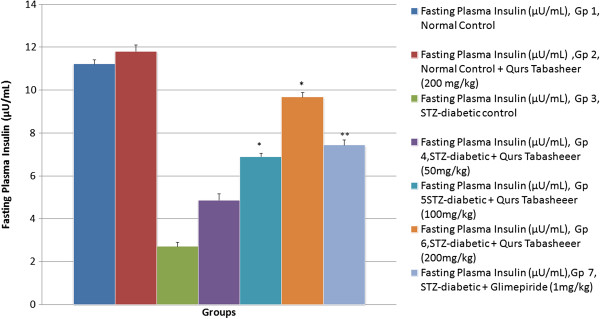
Effect of Qurs Tabasheer on level of plasma insulin at different concentrations on normal and STZ induced diabetic rats, compared to standard drug Glimepiride; values are mean ± SEM; n = 6; *P < 0.05; **P < 0.01; ***P < 0.001; P > 0.05 is considered as non-significant (ns).